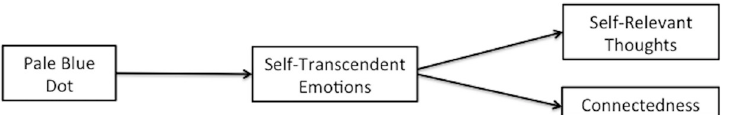
Fig 2. Conceptual model of indirect effects of self-transcendent emotions on self-relevant thoughts and connectedness (Study